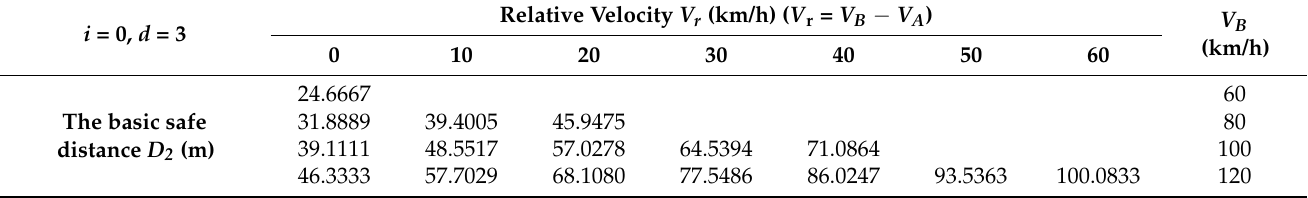
Table 3. The basic safe distance D 2 based on V B between 60 and 120 km/h when i = 0 and d =